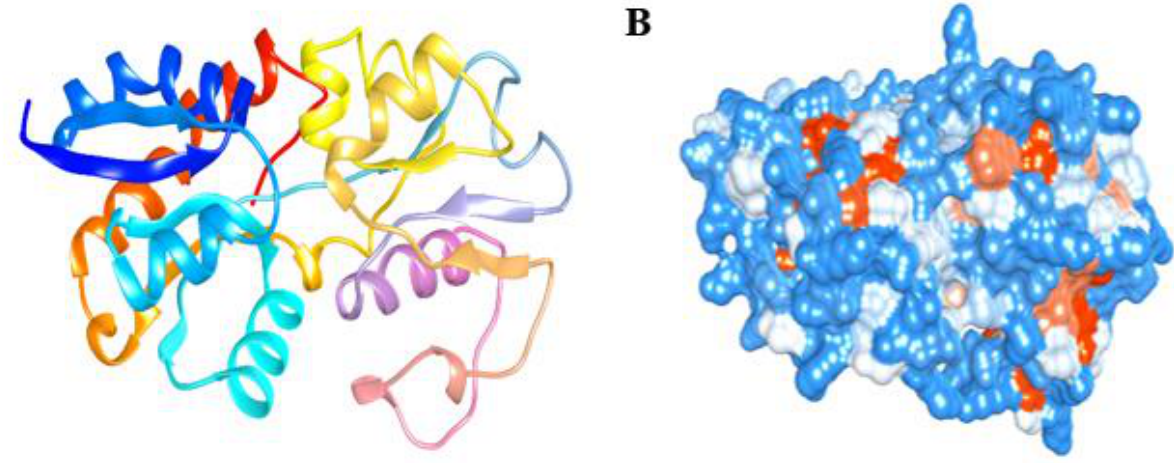
Figure 4. Homology model of Lpp protein. The protein is displayed by molecular 3D view with the representation of a rainbow color pattern from N-terminal to C-terminal ( A ), and the solid surface representation of Lpp as shown by hydrophobicity surface view ( B ), and it is best for showing the shape of the pocket. The surface view color pattern indicates most hydrophilic residues in blue, the strongest hydrophobic residues in orange red and the intermediate residues in white.